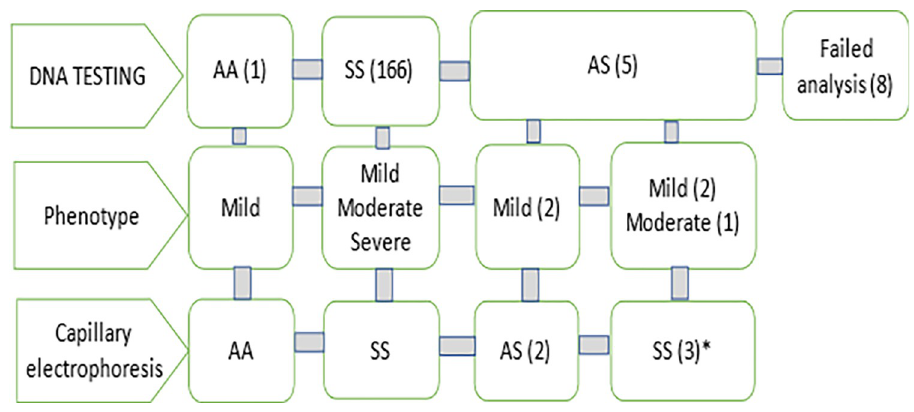
Fig 1. Diagnostic evaluation in 180 patients followed for sickle cell